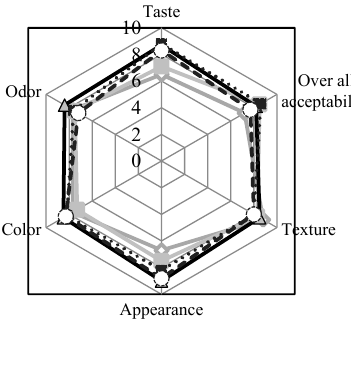
Figure 3. Acid value (AV) as free fatty acid (FFA) percent of the extracted oil from different probiotic potato chips samples. Potato chips containing probiotic Bifidobacterium longum and Lactobacillus helveticus (lyophilized in skim milk or gelatin/glycerol medium) or without LAB (control), were analyzed after storage at 30 °C for 4 months. a–d Di ff erent letters in the columns di ff er significantly ( p < 0.05).